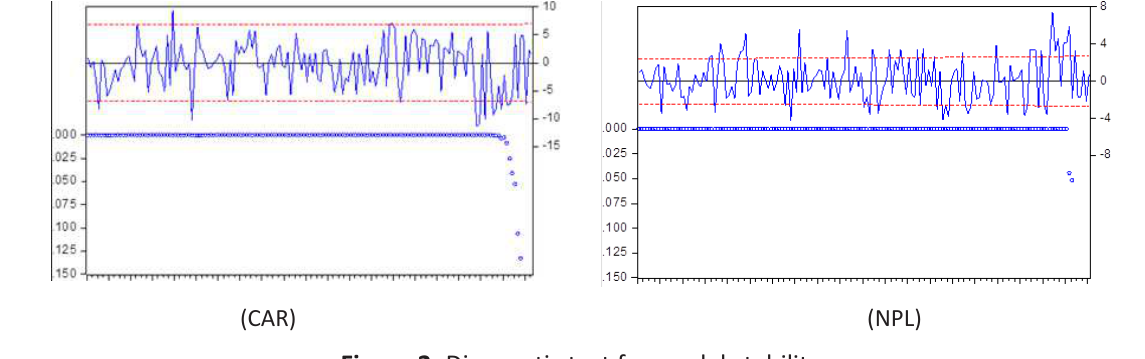
Figure 2. Diagnostic test for model